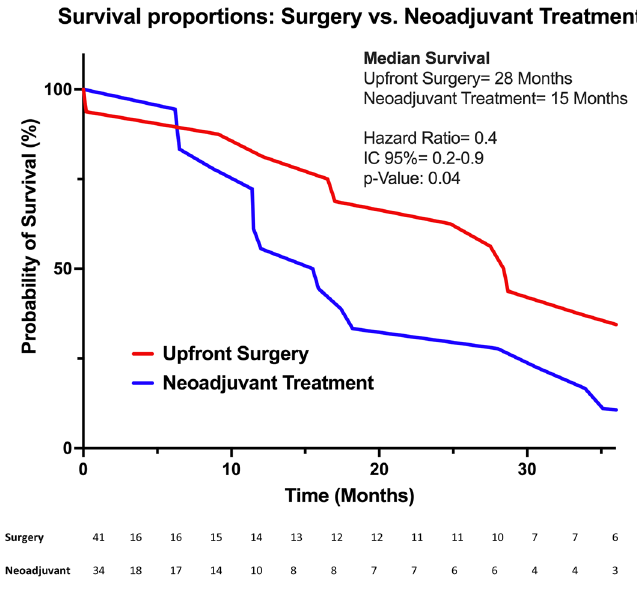
Figure 3. Overall survival in upfront surgery versus neoadjuvant treatment.